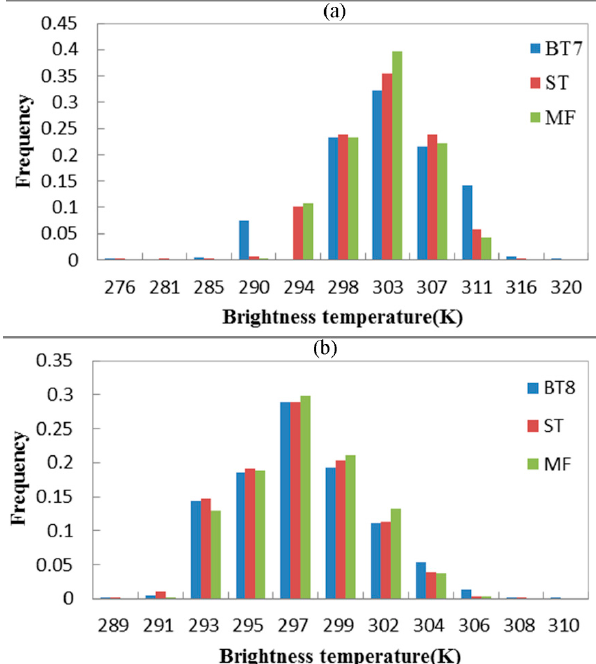
Figure 12. Frequency histograms of the background BT predictions and the actual BTs measurements from band 7 ( a ) and band 8 ( b ). “BT” denotes the actual background BT measurements, “ST” denotes the background BTs predicted using STM, and “MF” denotes the background BTs predicted by averaging the neighboring pixels.